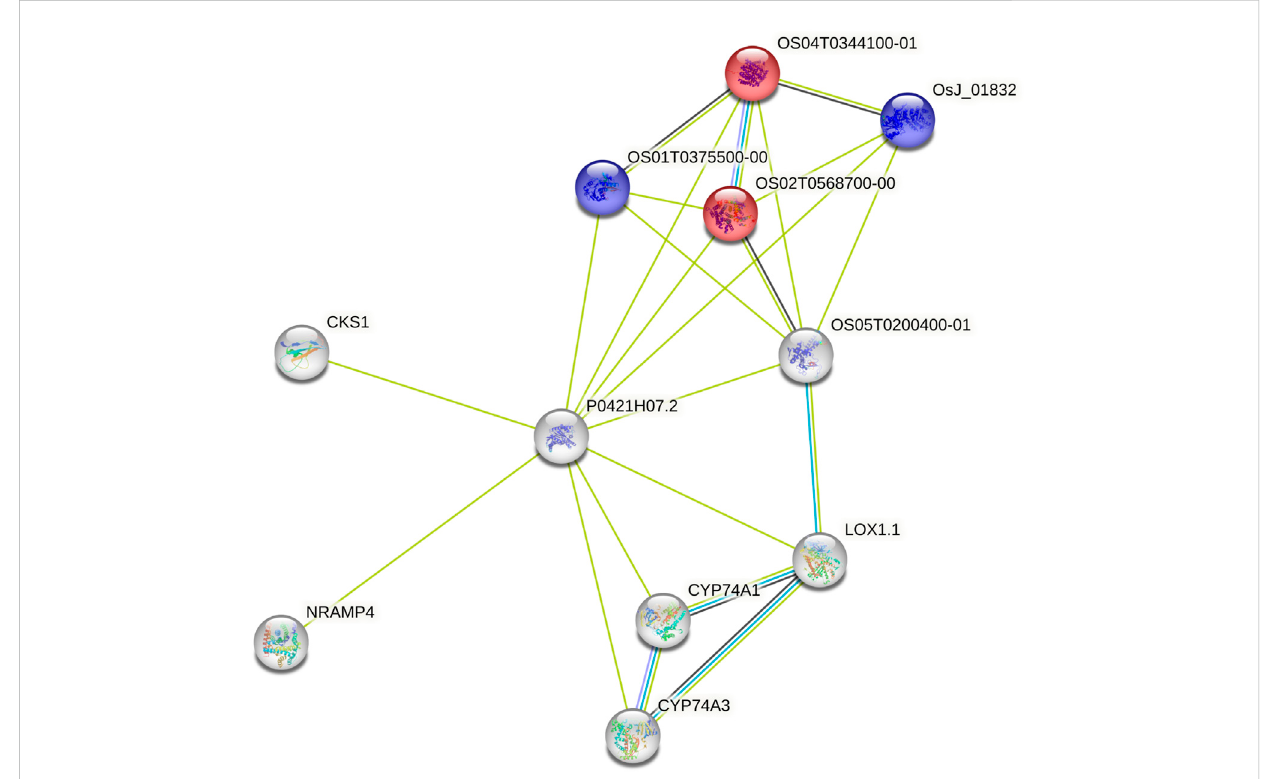
FIGURE 8 Protein-Protein Interaction Network for the rice ortholog (P0421H07.2) of Sobic.003G269700. Interaction types were represented by different colored edges between nodes that represent genes. Functional KEGG pathways involved in terpene synthase activity (red) and the Shikimate metabolic process (blue) are highlighted. Network results were generated using the String protein-protein interaction database (Szklarczyk et al.,